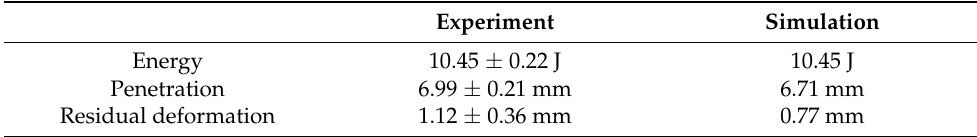
Table 8. The penetration of the sample by impactor.